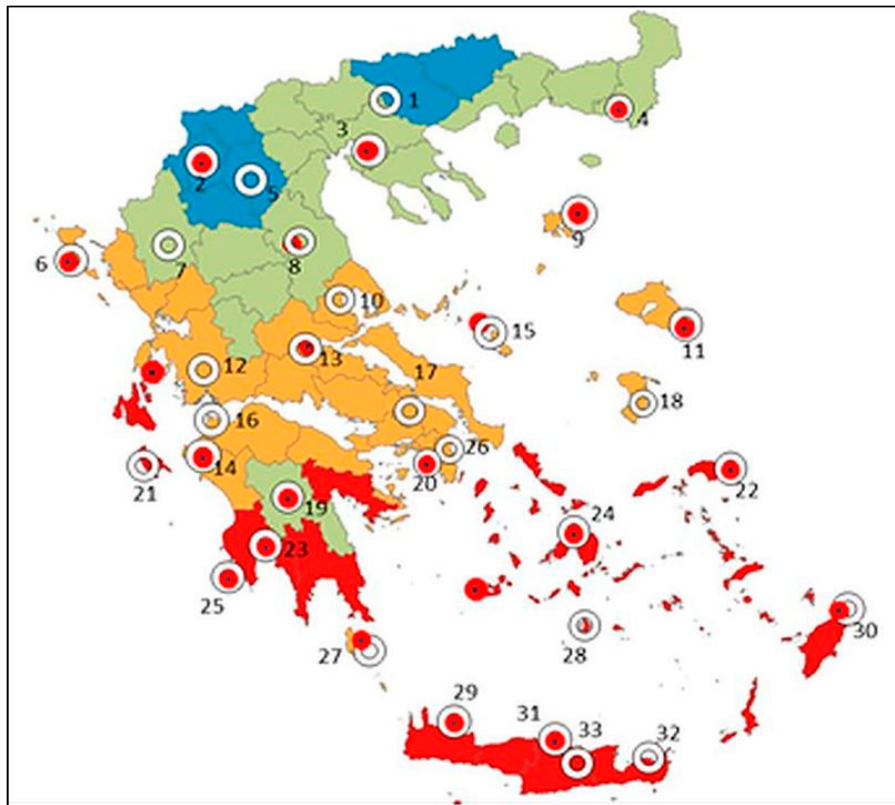
Figure 3. Map of Greece showing the location of the 33 Hellenic National Meteorological Service (HNMS) stations (white circles) across the 4 climatic zones: A (red), B (orange), C (green), and D (blue) according to TOTEE (Technical Guide of the Technical Chamber of Greece) [62]. The numbers in the map correspond to those in the first column of Table 2. The red dots correspond to locations in which IWYEC2s (International Weather Years for Energy Calculations) have been derived by ASHRAE (American Society of Heating, Refrigerating and Air-Conditioning Engineers) [65] in the period 1982–1999; they are shown for comparison. Table 3. Range of annual heating degree days (HDD), cooling degree hours (CDH) and available SSR (surface solar radiation) values to define the climatic zones in Greece for energy saving in buildings [61]. The calculation of HDD and CDH considers the following cold and warm periods of the year: